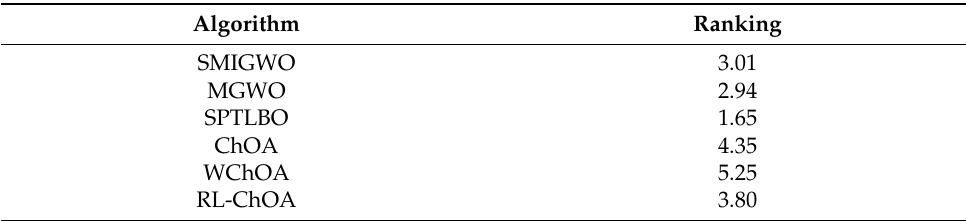
Table 5. Average rankings of the algorithms (Friedman) on fixed-dimension multi-modal bench- mark